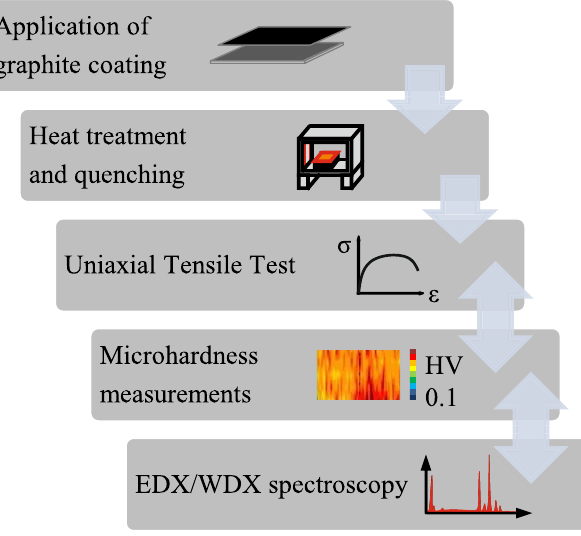
Fig. 3. Tensile strength of coated and uncoated specimens after a heat treatment at 900 ° C.